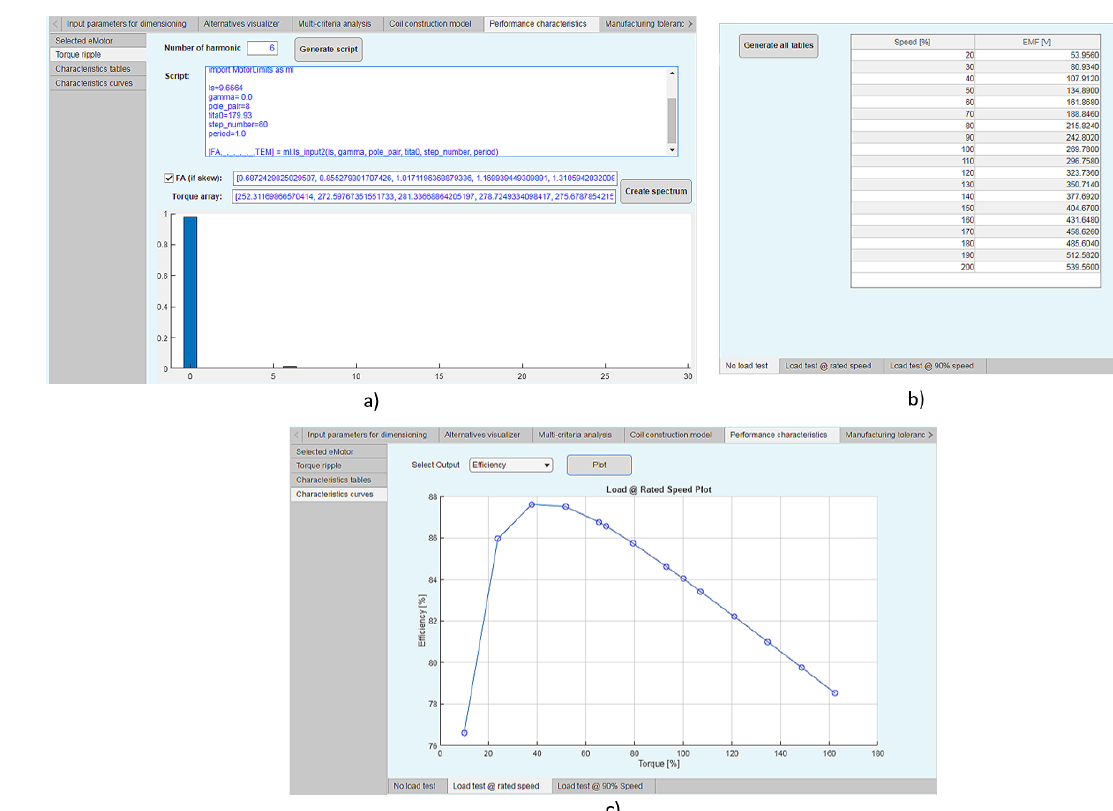
Figure 16. Example of characteristics computed for the selected motor ( a ), ( b ) and ( c ).